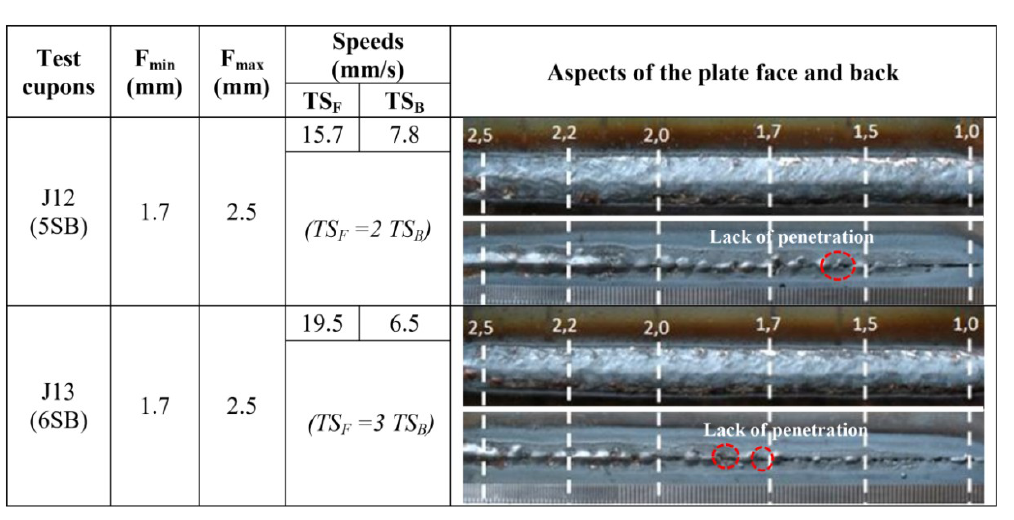
Figure 6. Quantification of the operational gap range for experiments 3SB and 4SB (switchback torch movement), where TS F ˂ TS B .